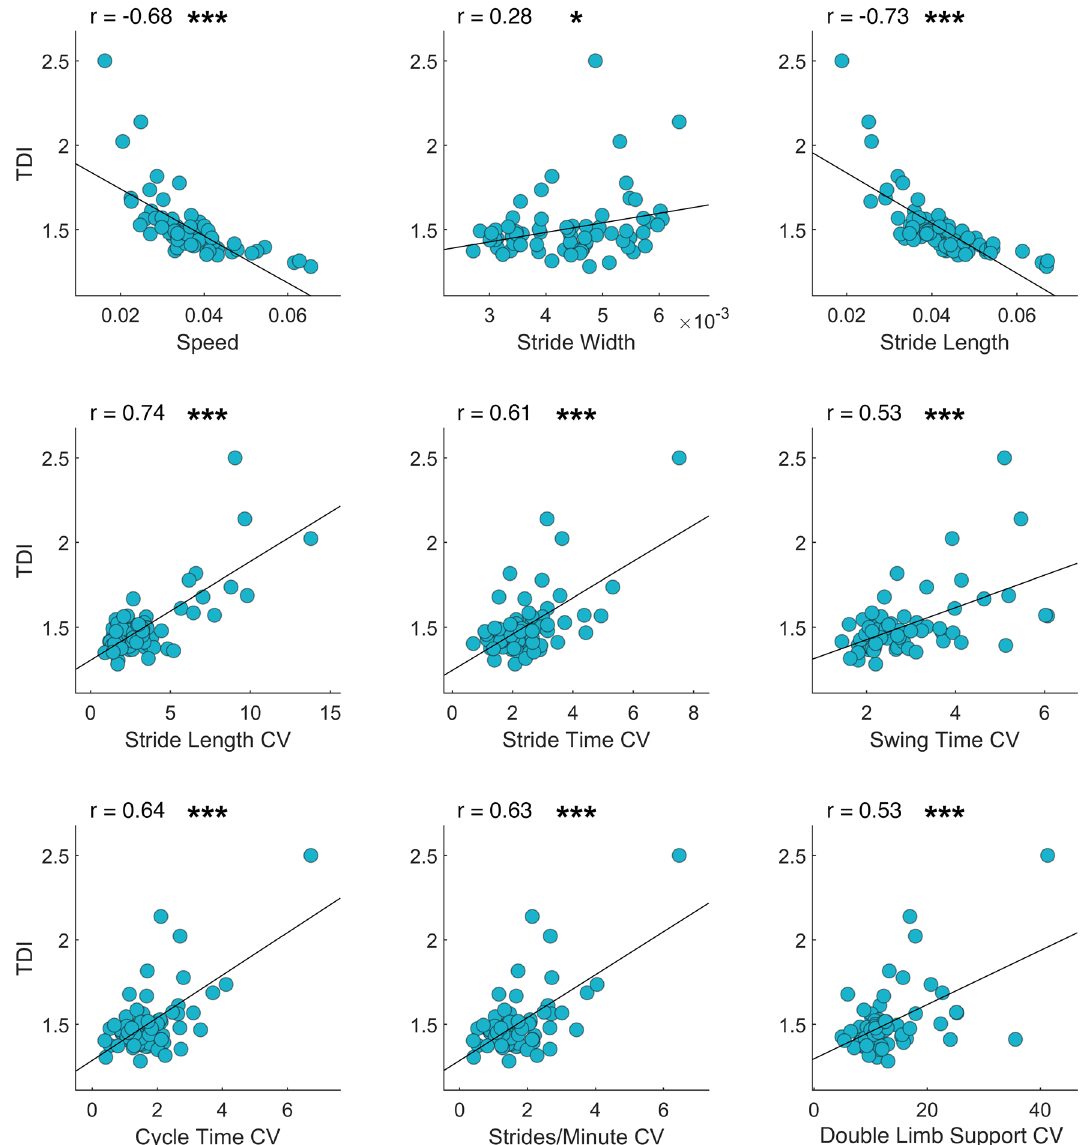
Figure 4. TDI and spatio-temporal gait parameters. Pearson coefficient correlation between trunk displacement index (TDI) and spatio-temporal gait parameters. The correlation includes healthy controls, individuals with Parkinson’s disease before L-DOPA intake, individuals with Parkinson’s disease after L-DOPA intake. Speed (m/s), Stride width (m), Stride length (m), Coefficient of variability (CV). Significance p value: * p < 0.05, ** p < 0.01, *** p <